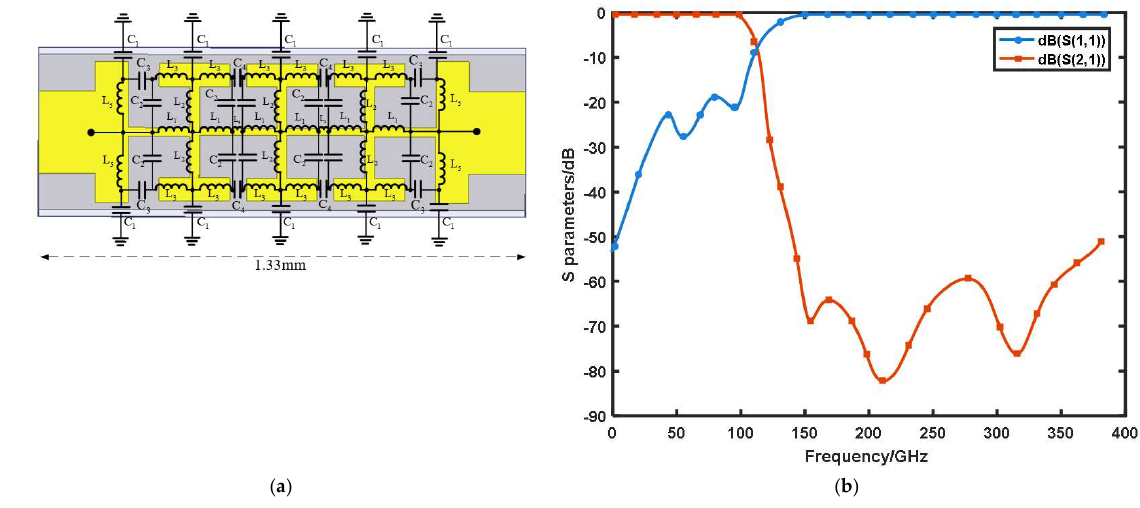
Figure 1. ( a ) Low–pass filter structure; ( b ) simulation results of low-pass filter.